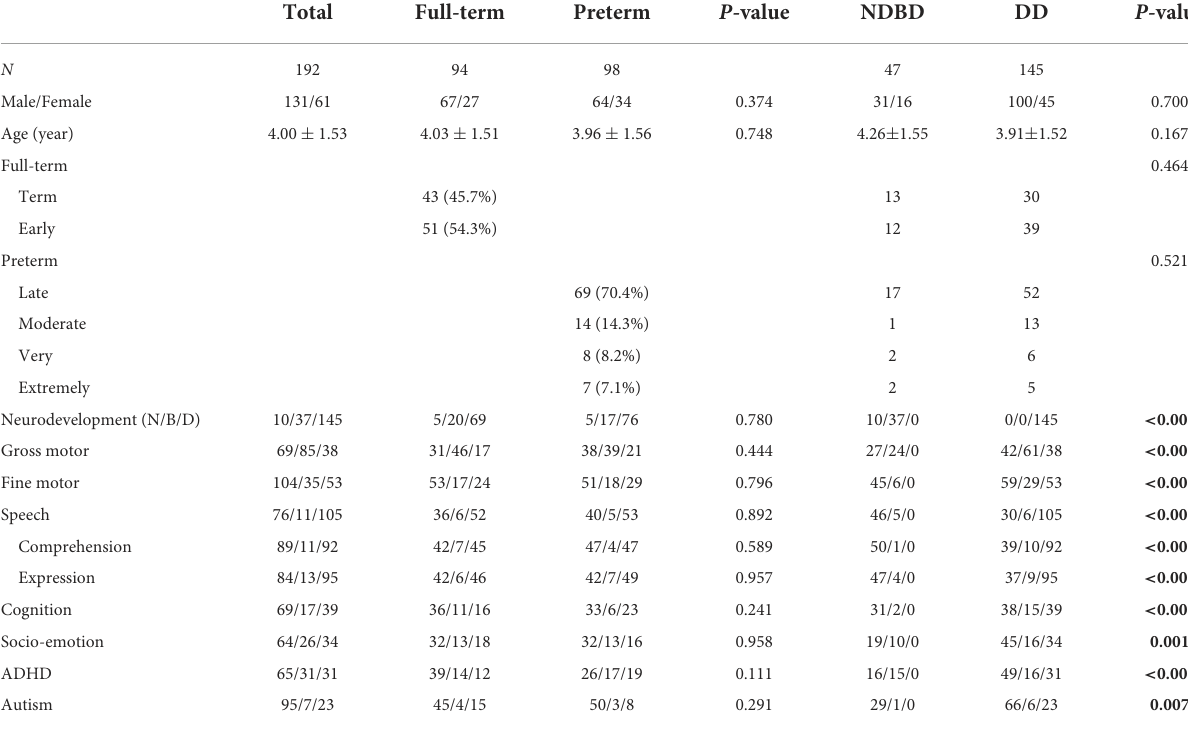
TABLE 1 Epidemiological and neurodevelopmental status of the subjects. Total